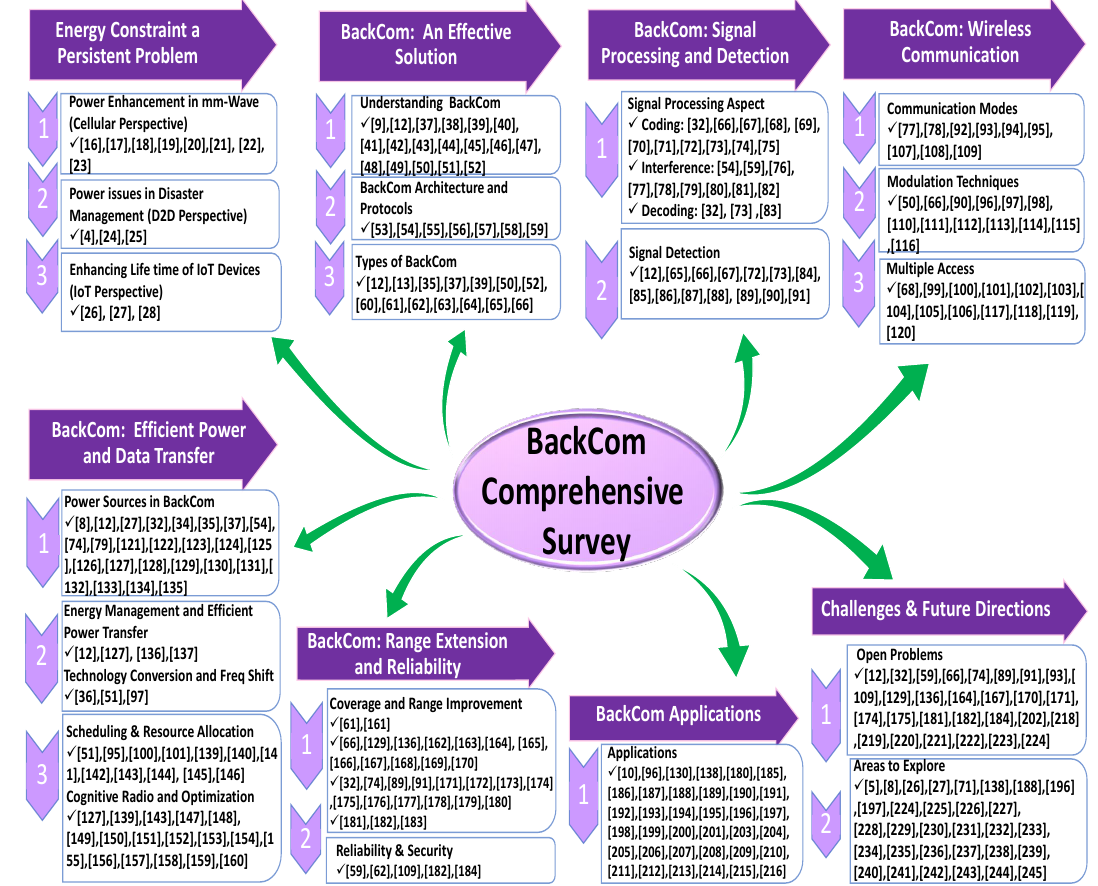
Figure 4. Overview of our survey